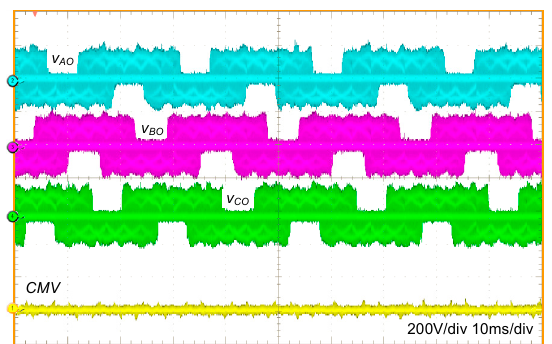
Figure 19. The phase to neutral voltage and the common mode voltage.